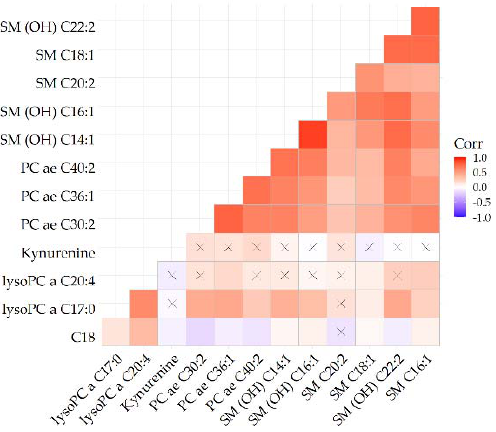
Figure 3. Heatmap depicting correlations of metabolites identified in Figure 1. For reference, blue indicates an inverse and red indicates a direct association. The stronger the color the stronger the correlation. Crossed cells indicate a non ‐ significant